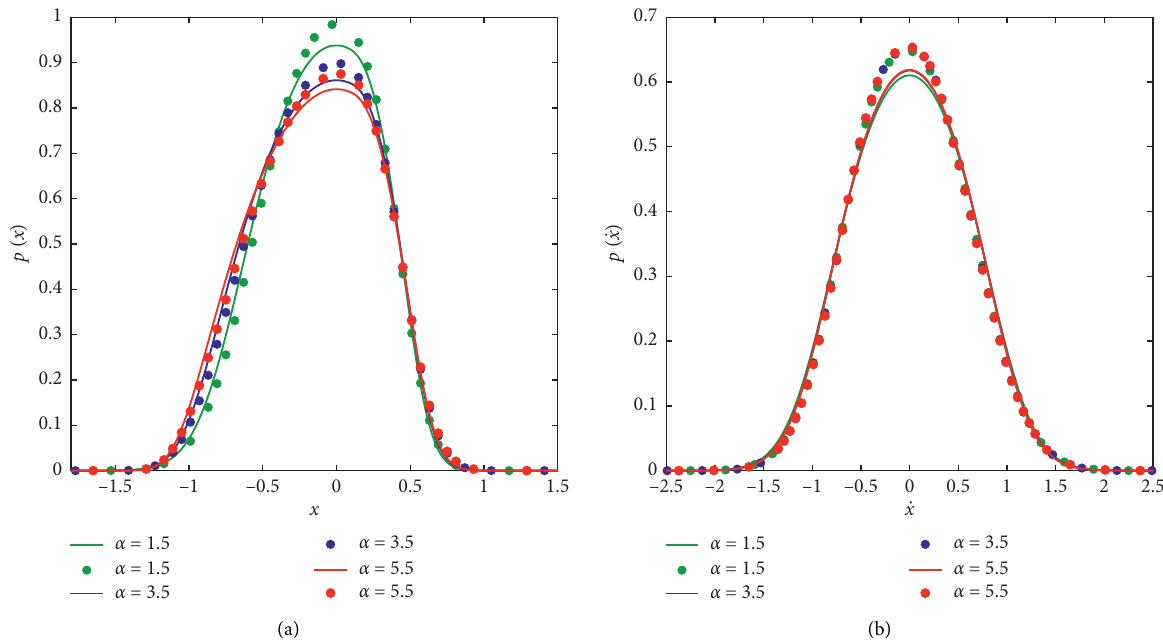
Figure 3: The PDF of the nonlinear system under a different fractional order α . (a) The displacement PDF; (b) the velocity PDF ( k lines: the analytical results, and circles: MCS results).